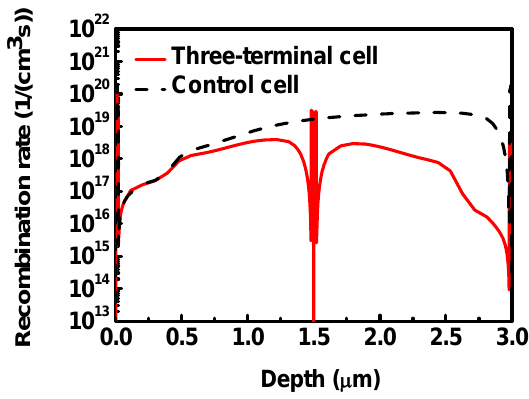
Figure 5. The recombination rate of the three-terminal cell and the two-terminal (control) cell. The three-terminal cell has a lower recombination rate than the control